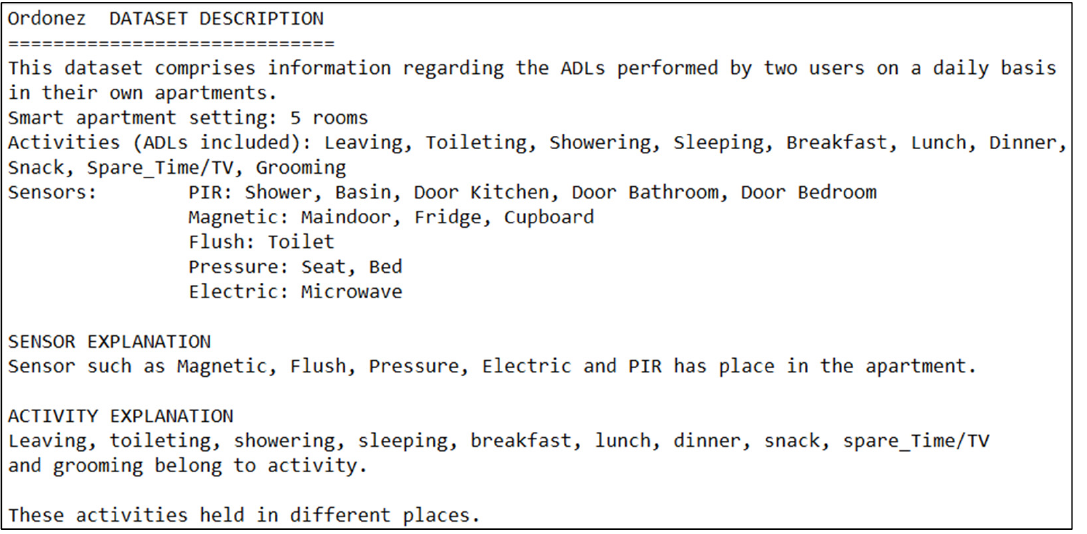
Figure 8. A sample fragment of the Ordonez metadata.